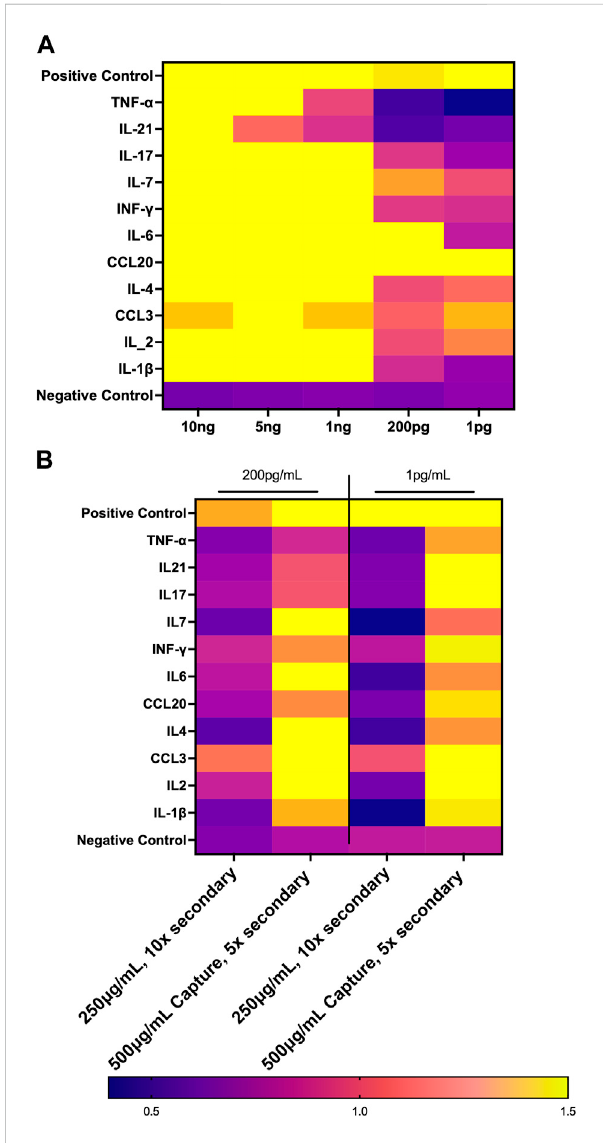
FIGURE 10 Optimization of First Generation GCFP Chip. (A) Measurements of the limit of detection for 11 analytes from the fi rst-generation biosensor chip. 1 ng/mL is the limit of detection for most analytes in this assay. (B) Optimizing reagents can increase the limit of